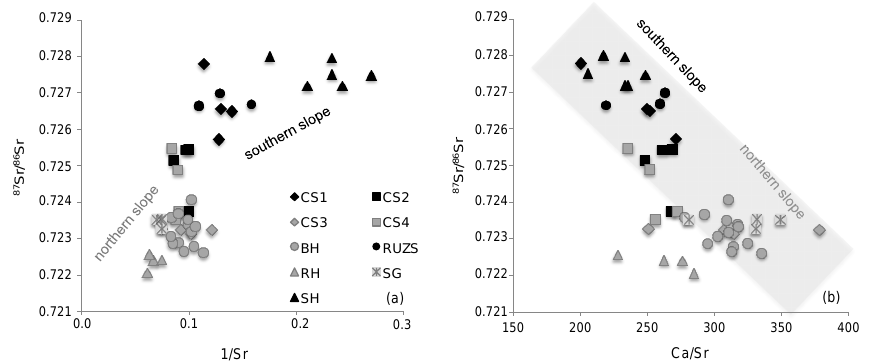
Figure 4. Relationships between 87 Sr / 86 Sr isotope ratios and (a) 1 / Sr (ppb); (b) Ca / Sr (ppbppb − 1 ). The isotope ratios allow a clear distinction between northern and southern slope